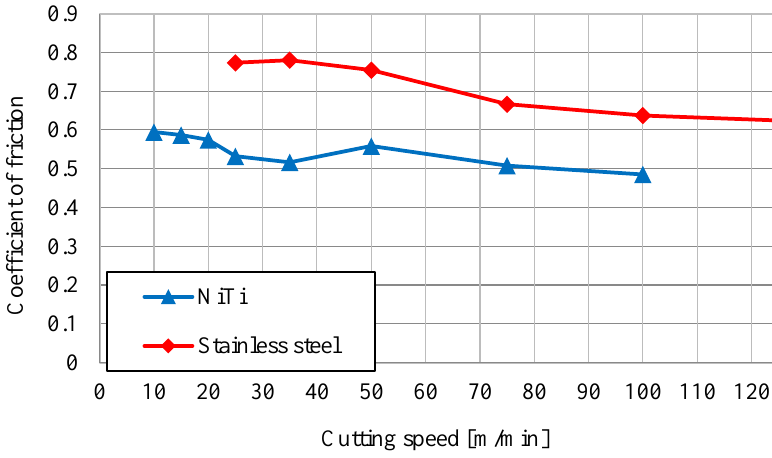
Figure 13. Coe ffi cient of friction calculated from the shear surface Figure 13. Coefficient of friction calculated from the shear surface theory.